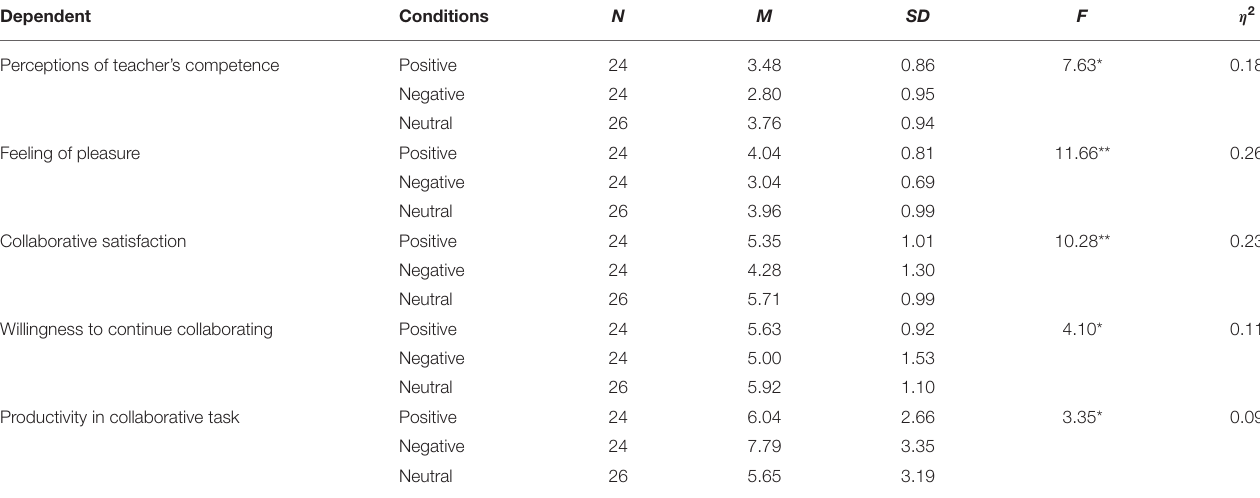
TABLE 2 | Results of descriptive statistics and univariate ANOVAs on variables. Dependent